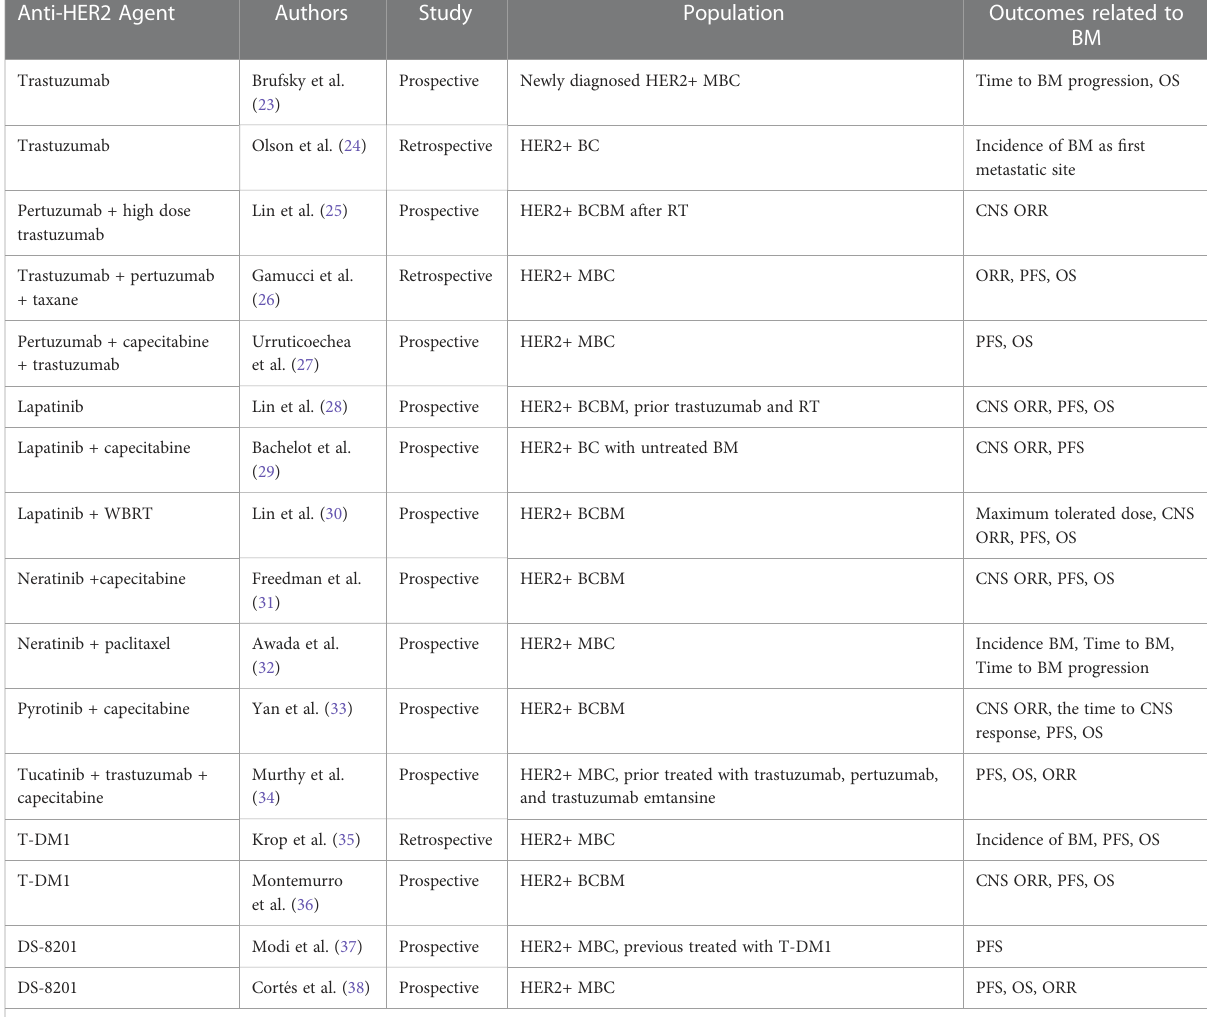
TABLE 1 Characteristics of studies reporting on outcomes related to BMs in patients with HER2-positive BC. Anti-HER2